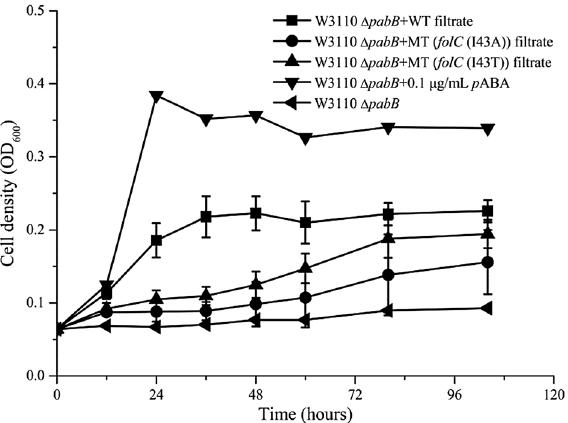
Figure 4. Mutation of folC caused decreased production of p ABA. Growth curves of E. coli W3110 Δ pabB were measured in the presence of p ABA and culture filtrates from wild-type H37Ra (WT-filtrate) and the two H37Ra folC mutant strains (MT-filtrates). Experiments were performed in triplicate. Standard deviations are indicated by error